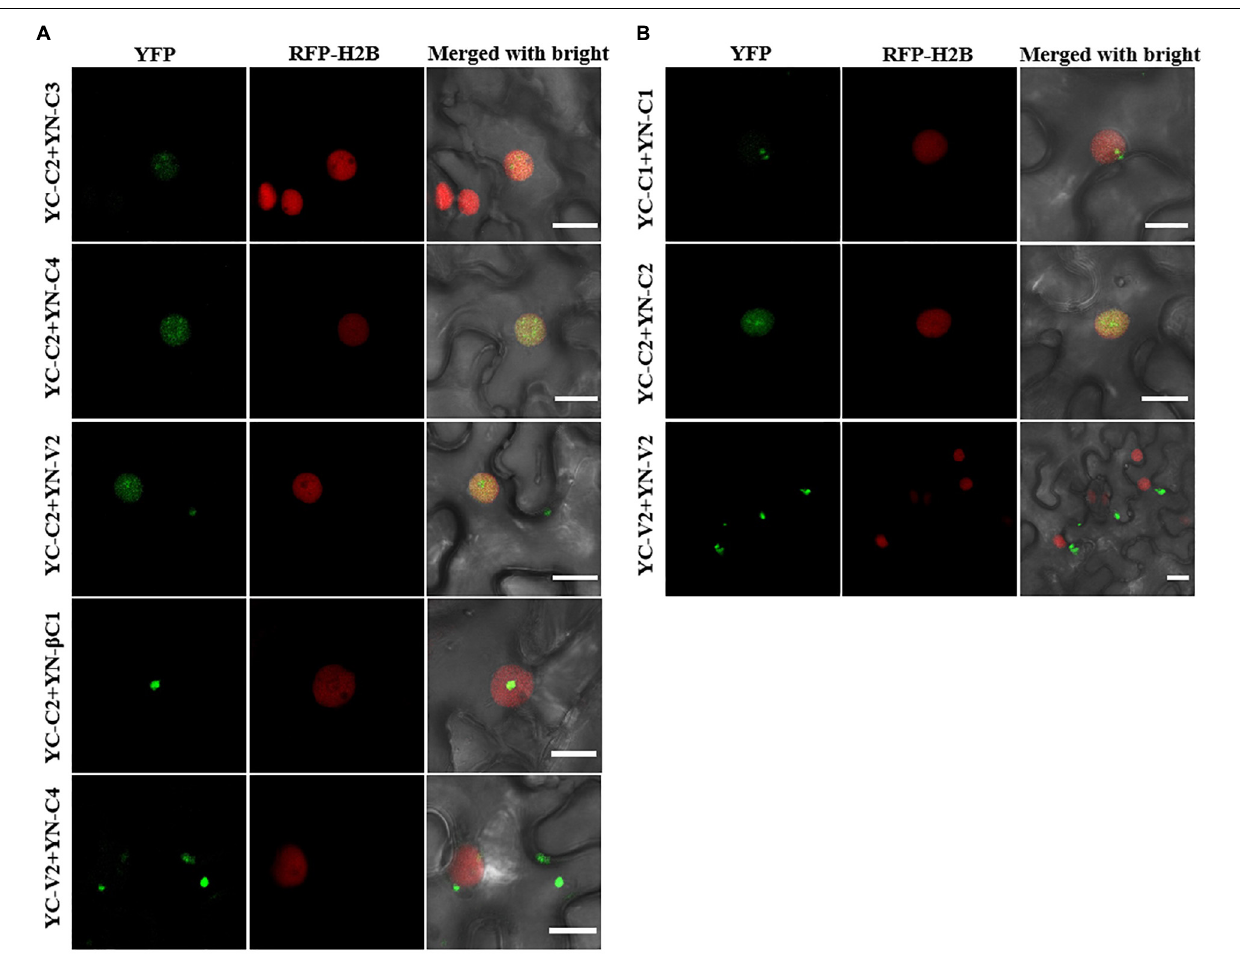
FIGURE 7 | BiFC assays to confirm the interactions among TYLCCNV/TYLCCNB-encoded proteins. (A) Confocal visualization of the interaction between C2 and C3, C2 and C4, C2 and V2, C2 and β C1, and C4 and V2 in RFP-H2B transgenic N. benthamiana leaves. The fused proteins indicated above were transiently expressed in RFP-H2B transgenic N. benthamiana leaves. Images were taken at 48 hpi. Yellow fluorescence (in green) was found in the leaf cells co-expressing C2 + C3, C2 + C4, C2 + V2, C2 + β C1, and C4 + V2. Nuclei of tobacco leaf epidermal cells are indicated by RFP-H2B (red). Bars, 10 µ m. (B) Confocal visualization of the self-interaction of C1, C2, and V2. C1, C2, and V2 were fused with YN or YC, respectively. Yellow fluorescence (in green) was found upon pairwise expression of YN-C1 + YC – C1, YN – C2 + YC – C2, and YN – V2 + YC – V2 at 48 hpi. Bars, 10 µ m. These experiments were repeated three times by three independent infiltrations; one representative result is shown (A,B)